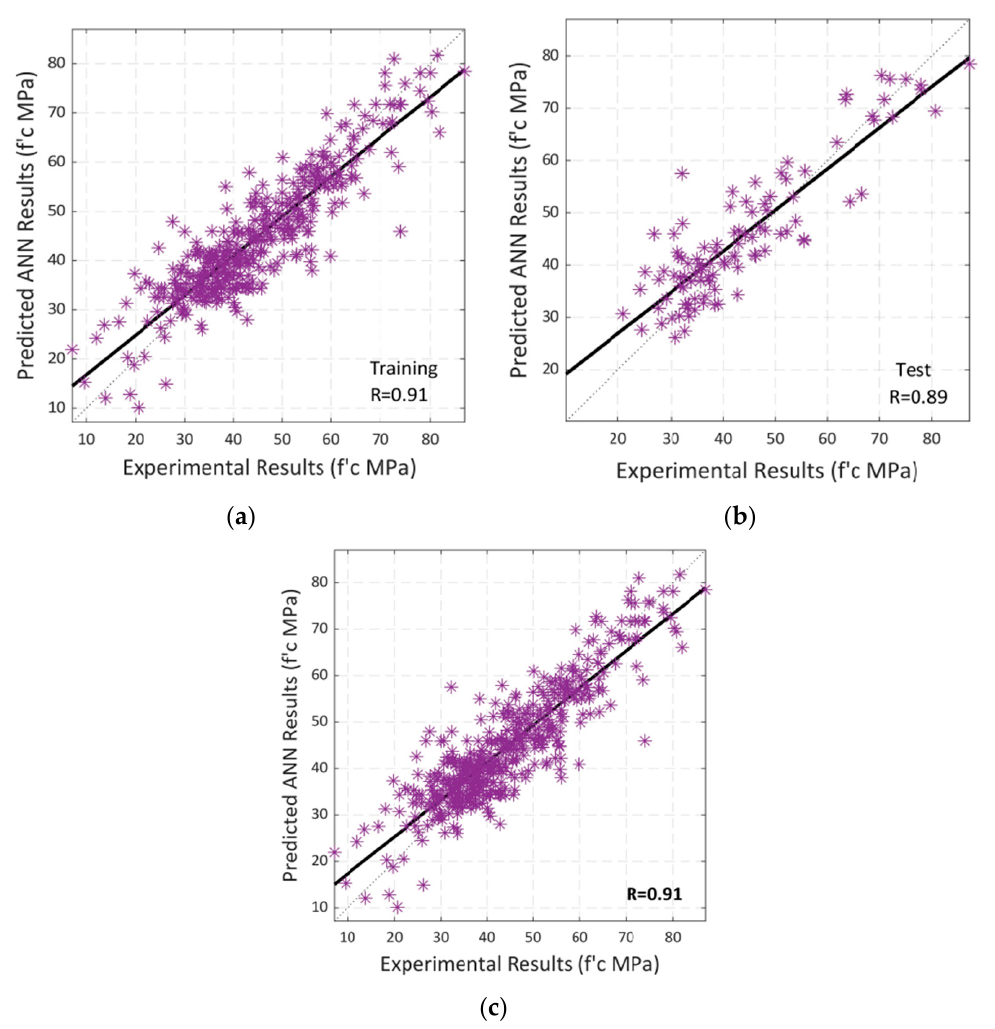
Figure 15. Regression analysis by using BR algorithm between experimental and predicted compressive strength: ( a ) Training; ( b ) Testing; ( c ) Overall Dataset.